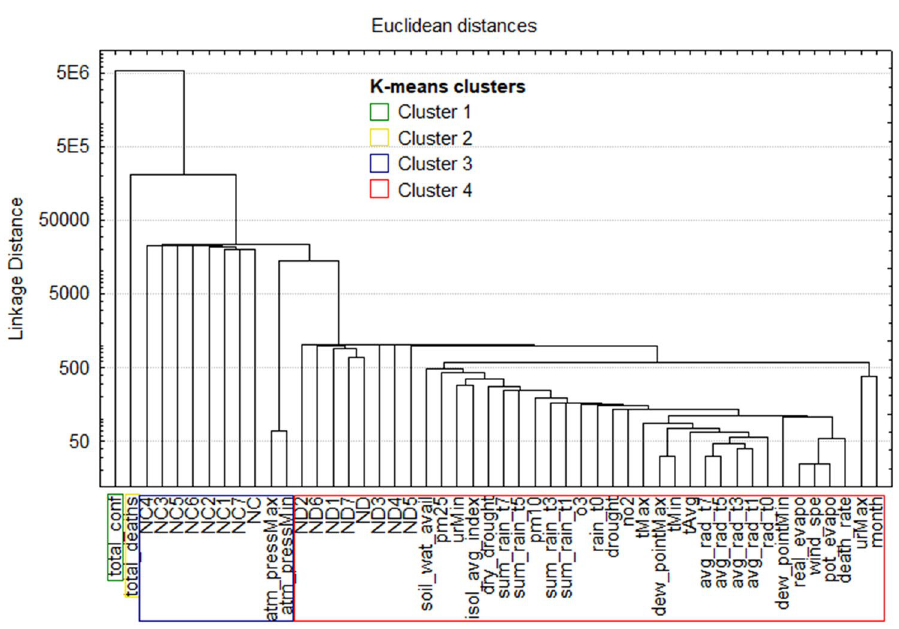
Figure 4. Dendrogram and K-means clusters of SP (generated by the Statistica 7 software—https:// stati stica. softw are. infor mer.